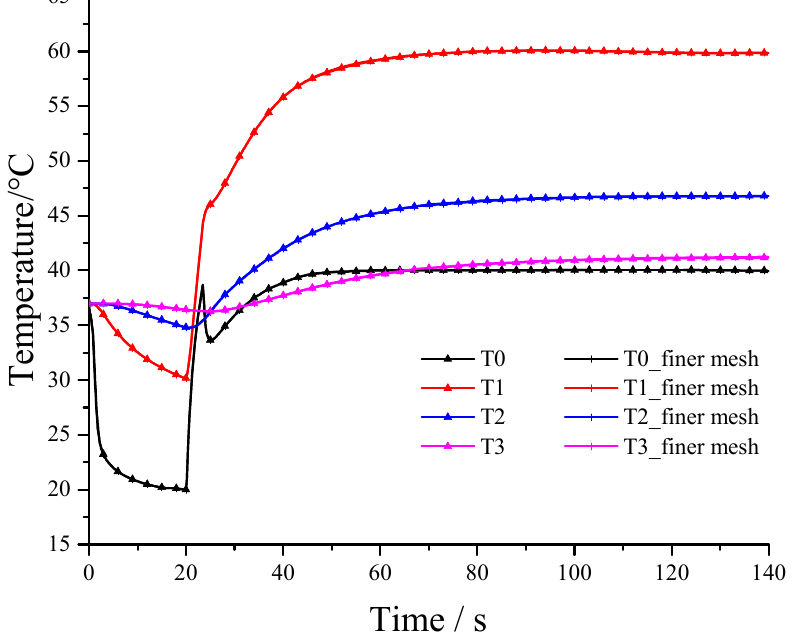
Figure A5. Heating curves at different points (T0, T1, T2, and T3) to compare the convergence of the models with different mesh densities. The mesh elements increased from 380825 to 1381825.